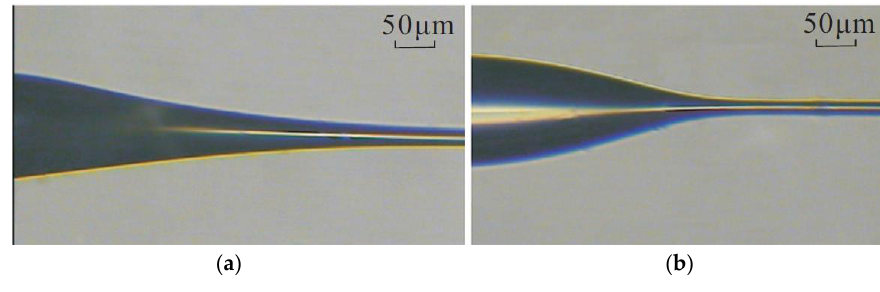
Figure 4. The adiabatic taper ( a ) and non-adiabatic taper ( b ) [74].